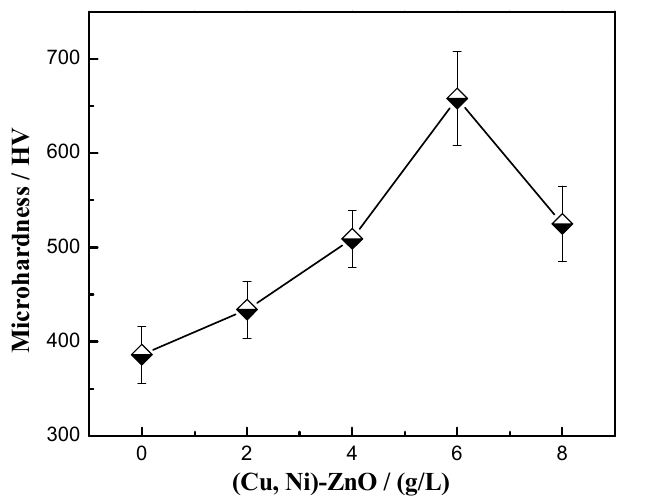
Figure 6. Microhardness of Cu-Ni-ZnO nanocomposite coatings with different (Cu, Ni)-ZnO addi- tions.